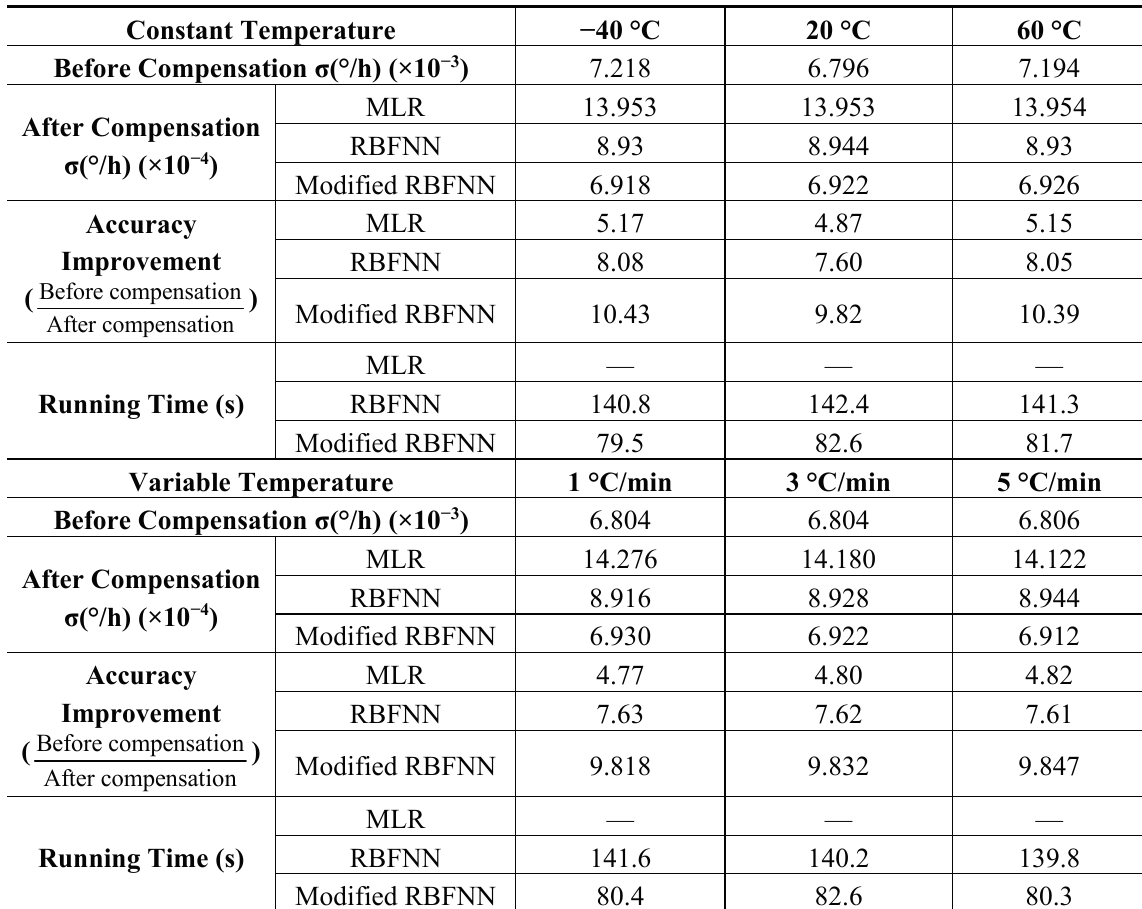
Table 1. Comparison of compensation results of the three